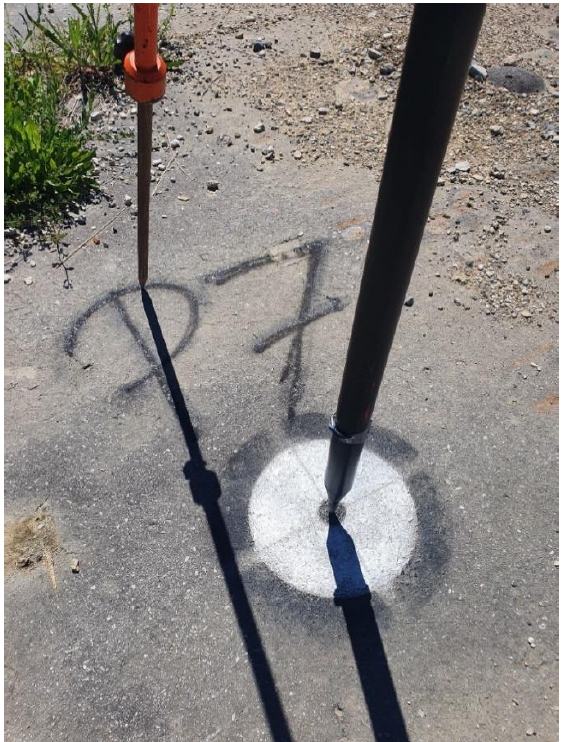
Figure 2. Marked GCP on the study site in the city of Samobor, Croatia.